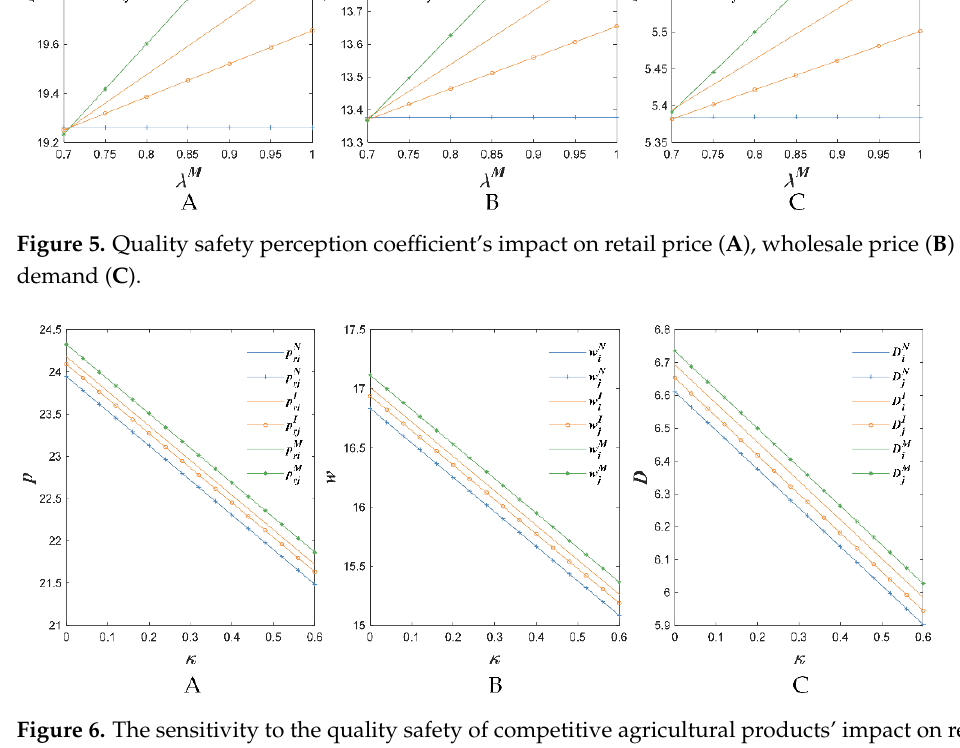
Figure 6. The sensitivity to the quality safety of competitive agricultural products’ impact on retail price ( A ), wholesale price ( B ) and demand ( C price ( A ), wholesale price ( B ) and demand ( C ).